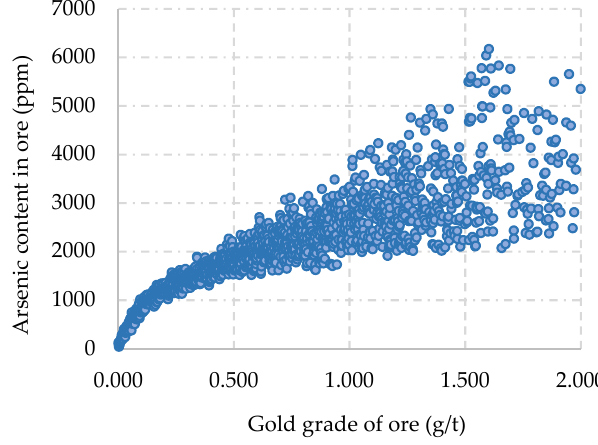
Figure 4. Scatterplot of arsenic versus gold grade.